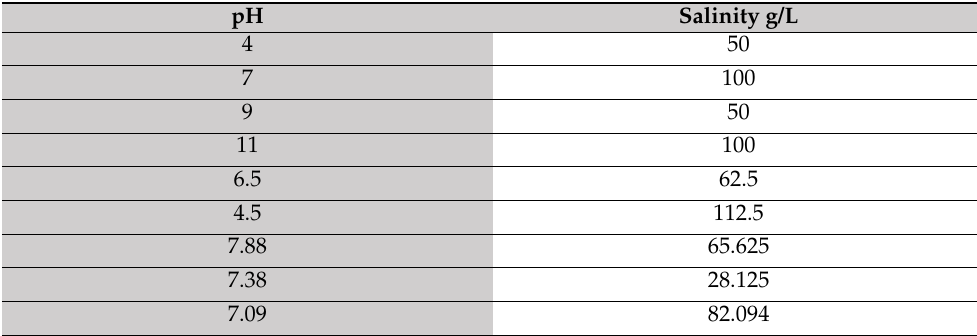
Table 5. Vertexes of the simplex